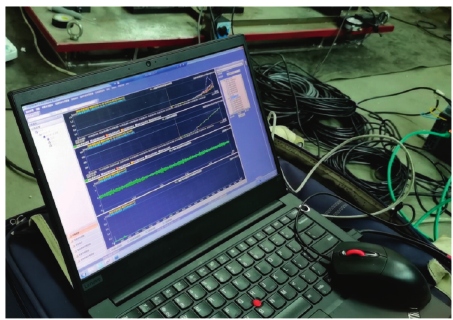
Figure 7: The computer to save the